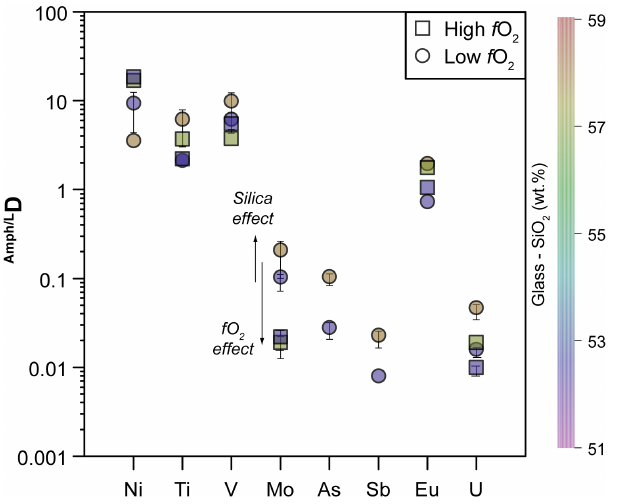
Figure 9. Comparison between the Amph / L D of trace elements with multiple oxidation states obtained at low (circles) and high (squares) f O 2 conditions and similar SiO 2 content (wt%) of the glass in equilibrium with the amphiboles (color code on the right side of the diagram). Arrows show general trends induced by both silica content in the glass and f O 2 variations. See text for further expla- nation. When not visible, the error bar is smaller than the symbol.